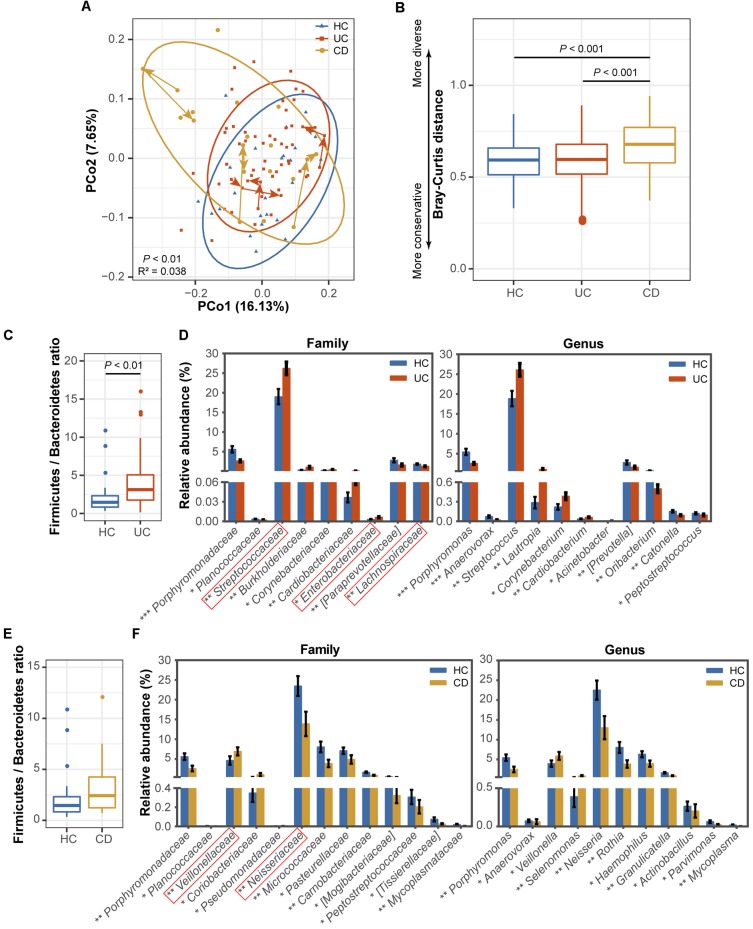
Comparisons of the phylogenetic structure and composition among the ulcerative colitis (UC, 54 subjects), Crohn’s disease (CD, 13 subjects) and healthy control (HC, 25 subjects) microbial communities. (A) Principal coordinate analysis (PCoA) based on unweighted UniFrac distances is shown for the UC (red) and CD (yellow) patients and healthy controls (blue). Ellipses represent a 95% confidence interval (CI) around the cluster centroid. Temporal changes from baseline to 1 and 2 months after baseline in the samples obtained from the 3 UC and 3 CD patients with active diseases are indicated by arrows. The 10,664 sequences were rarefied randomly for every sample before calculating pairwise distances. Statistical significance was examined using the Adonis method [nonparametric multivariate analysis of variance (MANOVA)] with 9,999 permutations. (B) A boxplot of the Bray-Curtis dissimilarity distance suggesting the degree of community conservation was performed within the three groups. P-values were calculated using 9,999 Monte Carlo permutations. (C) Comparisons of the Firmicutes/Bacteroidetes ratio and (D) taxonomic profiles at the family and genus levels between the UC and healthy populations are shown as a boxplot [median and interquartile range with whiskers) and bar plots (mean ± standard error of the mean (s.e.m.)], respectively. Red boxes in the bar plot emphasize the taxa in this study with the same variation tendencies in the gut (gut information was summarized from previous classical studies as available in Supplementary Table S4). The Wilcoxon rank-sum test was used for statistical comparisons. Significance is indicated by ∗ (∗∗∗ indicates P < 0.001, ∗∗ indicates P < 0.01, and ∗ indicates P < 0.05). (E) Comparisons of the Firmicutes/Bacteroidetes ratio and (F) family and genus profiles between CD patients and controls.